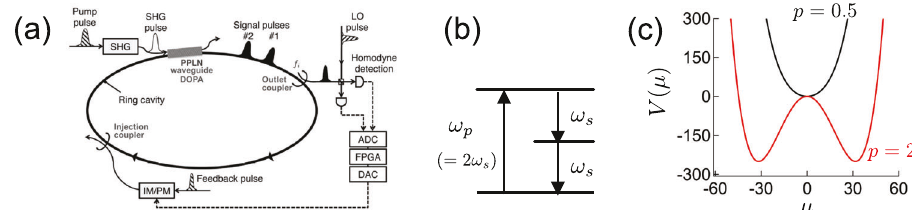
Fig. 1 Model of Coherent Ising machine (CIM). a CIM with measurement and feedback (cited from ref. 16 , SHG, ADC, FPGA, DAC, IM/PM, PPLN, and LO represent second harmonic generation, analog-to-digital converter, fi eld programmable gate array, digital-to-analog converter, intensity modulator/phase modulator, periodically poled lithium niobate, and local oscillator, respectively). b χ (2) interaction of optical modes via virtual excitation of valence band electronic state. c Effective potential V ( μ ) of mean amplitude μ for p = 0.5 and 2 ( g 2 = 10 − 3